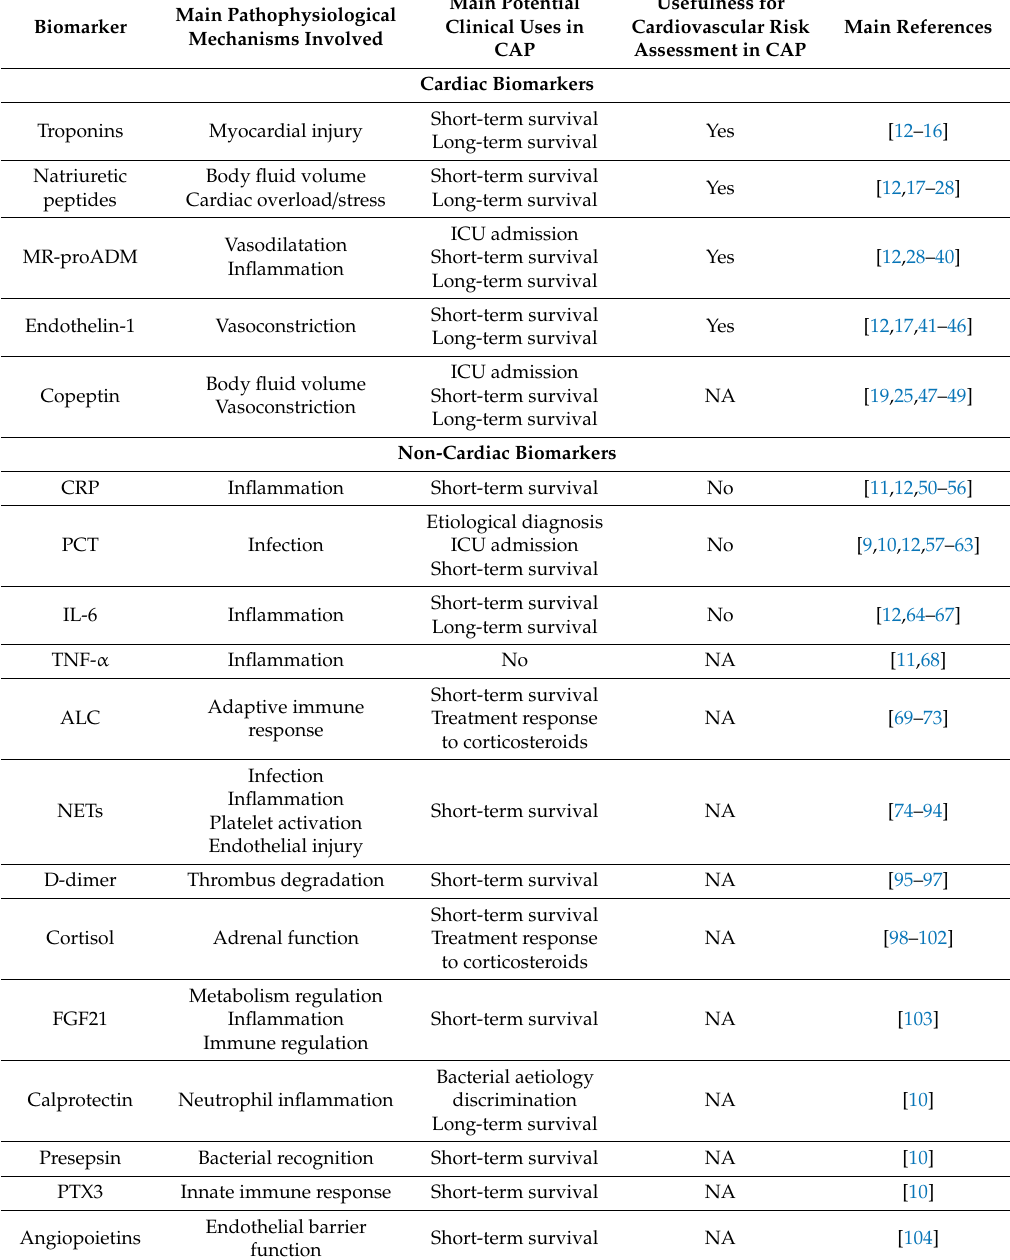
Table 1. Main cardiac and non-cardiac biomarkers in community-acquired pneumonia